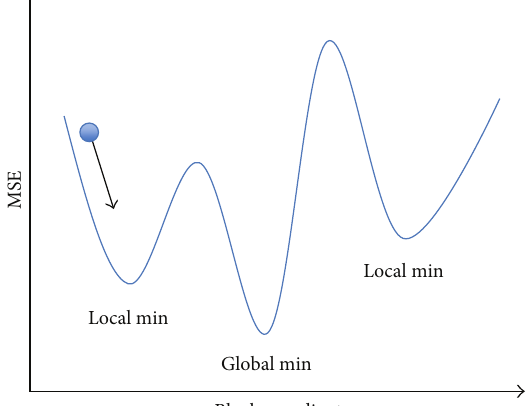
Figure 11: Fast block matching algorithm when getting stuck in the local